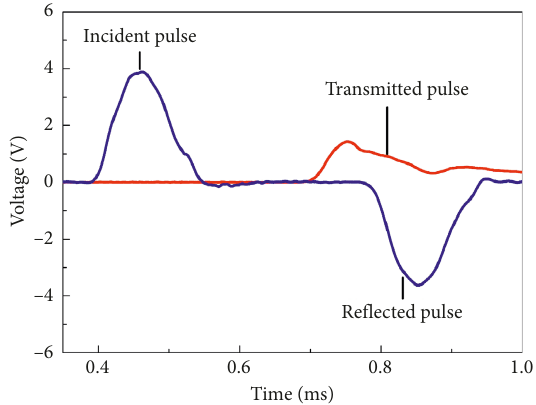
Figure 2: Original waveform diagram.